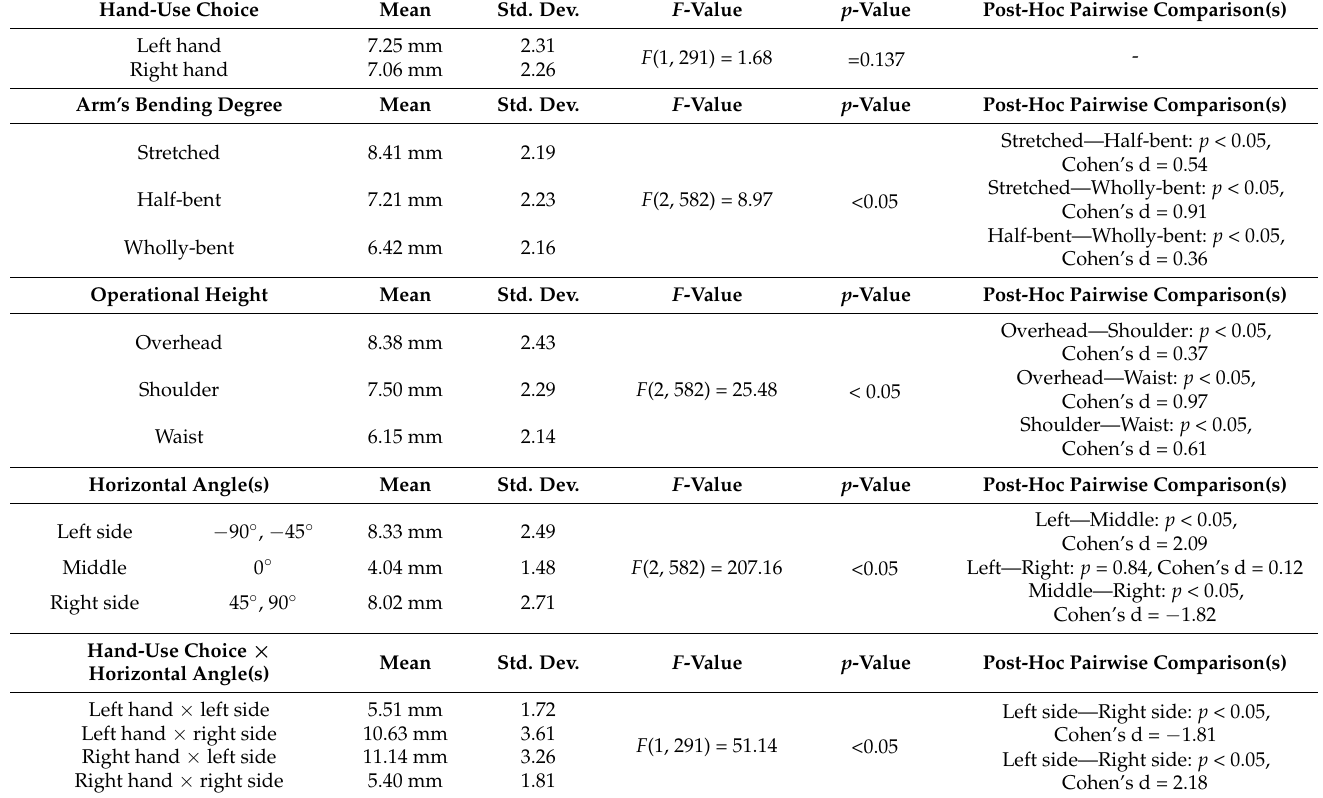
Table 4. Statistical analysis on the end-point scatter and pairwise